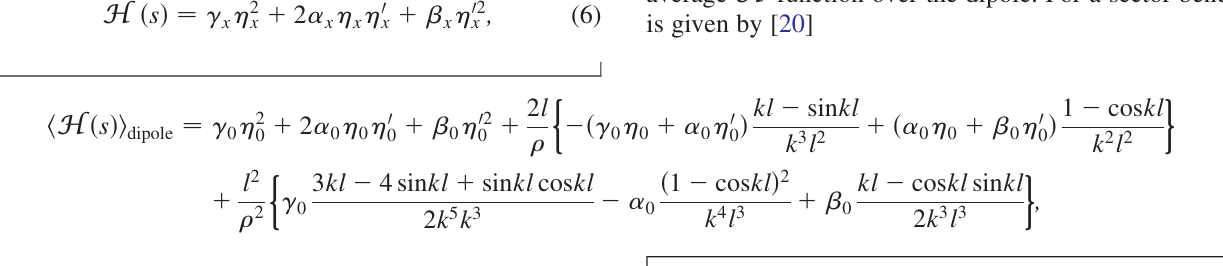
for given dispersion functions (cid:5) 0